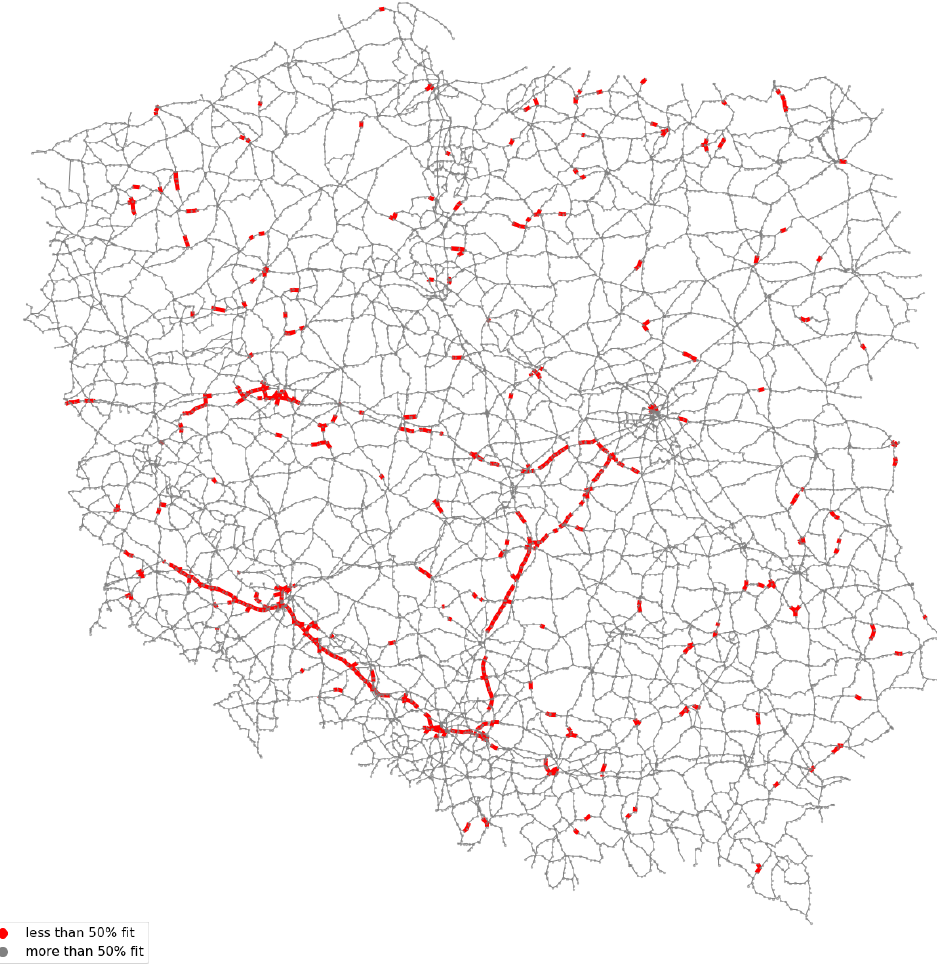
Figure 10. Sections of the road network with a degree of matching below 50%.